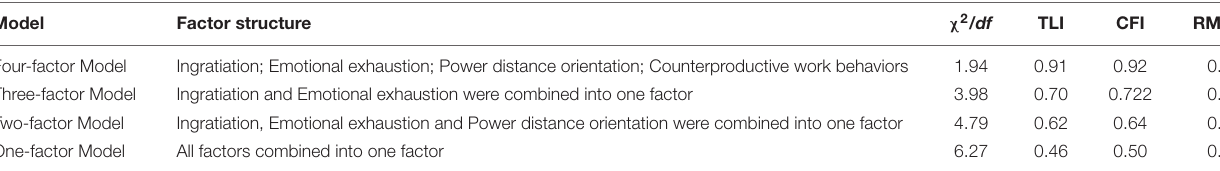
TABLE 2 | Means, standard deviations, and correlations.